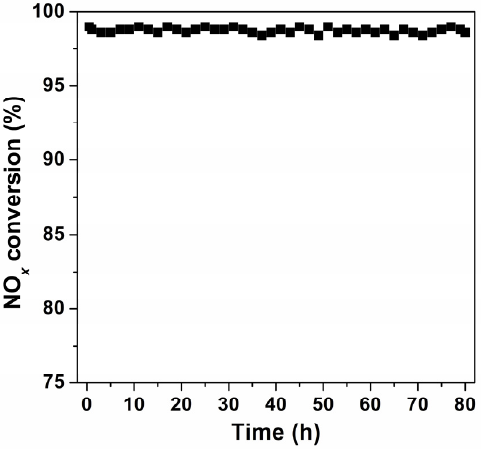
Figure 8. The long ‐ term stability test on Fe0.5 ‐ W ‐ Ce catalyst. Reaction conditions: [NO x ] = 450 ppm, [NH 3 ] = 450 ppm, 2.5% O 2 , N 2 as balance, GHSV = 20,000 h − 1 .